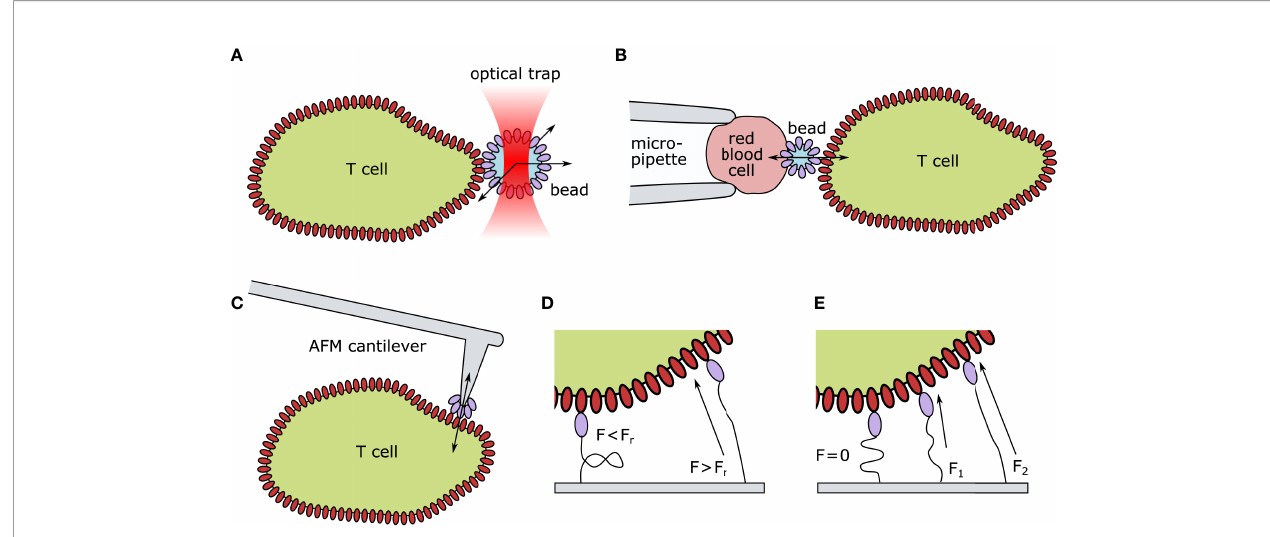
FIGURE 2 | Technical approaches for quantifying mechanical forces exerted on TCR – pMHC pairs. (A) Optical tweezer setup: ligand-coated beads are spatially fi xed by an optical trap. Upon TCR engagement, the bead is moved out of the laser focus. The de fl ection indicates the TCR-imposed mechanical force. (B) Biomembrane Force Probes: A T cell and a red blood cell are aspirated and held in place via a micropipette setup. A ligand-coated bead is attached to the surface of the red blood cells. Upon T-cell contact, altered thermal fl uctuation of the bead indicates TCR – ligand engagement. Forces can be exerted by retracting the micropipette. (C) Atomic Force Microscopy: A ligand-coated cantilever tip is brought into close proximity of the T cell surface. Upon TCR engagement, the de fl ection of the cantilever indicates force generation. (D) Digital Molecular Force Sensors (MFS): A ligand is attached to a fl uorescently labeled MFS unit. In their folded state, the fl uorescence is entirely quenched. Such sensors can withstand a certain threshold of strain before ( F r ) unfolding. Upon TCR engagement and force generation, the digital MFS unfolds, reducing the quencher ef fi ciency and leading to a quanti fi able increase in fl uorescence. (E) Analog MFS: A ligand is attached to a fl uorescently labeled spring unit framed with a FRET (Förster resonance energy transfer) pair. In its coiled state ( F =0) the fl uorophores are in close proximity and the FRET ef fi ciency is high. Upon TCR engagement and force generation (